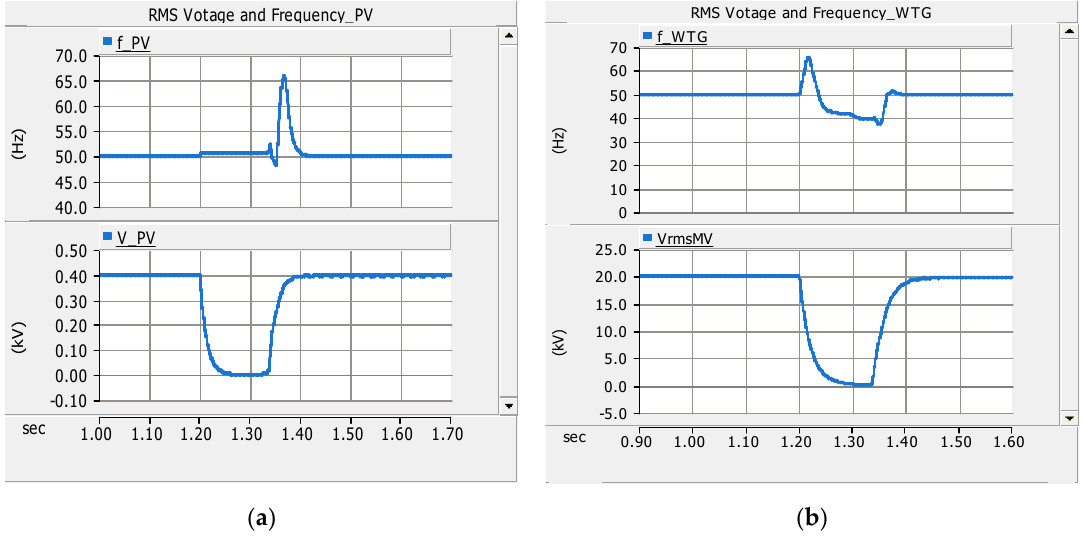
Figure 16. Three-phase RMS voltage and frequency of DGs before, during and after fault F1 ( a ) low-voltage (LV) side of the PV system and ( b ) medium voltage (MV) side of the WTG.